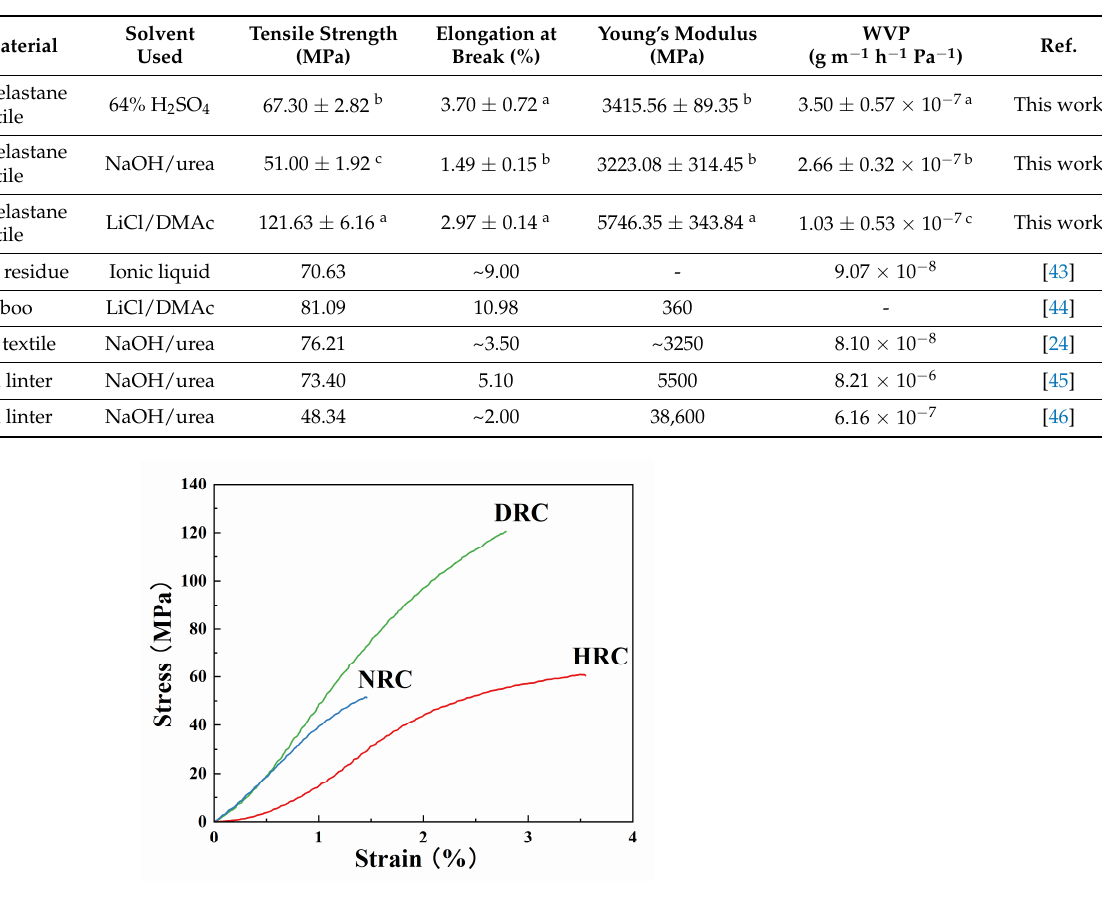
Table 2. Mechanical properties and water vapor permeability of regenerated cellulose films from various raw materials. Different letters in the same columns indicate the significant difference within this work ( p < 0.05).